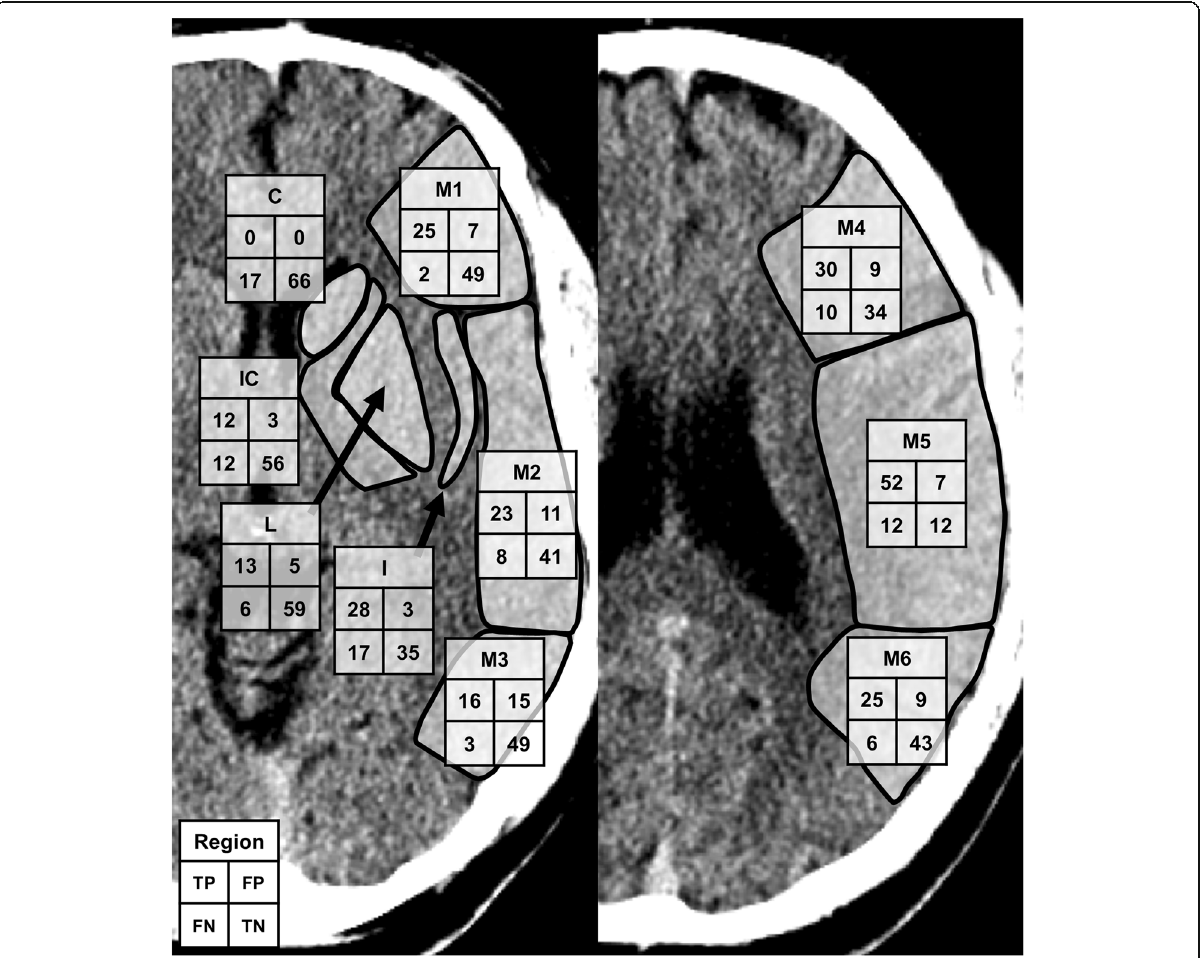
Fig. 3 Confusion matrices for the convolutional neural network (CNN) detections by the ten individual Alberta Stroke Programme Early CT Score (ASPECTS) regions (M1 – 6, C, IC, L, and I) for 83 patients. The total sums from the left and right hemispheres (whichever was the infarcted side) were combined for true positives (TP), true negatives (TN), false positives (FP), and false negatives